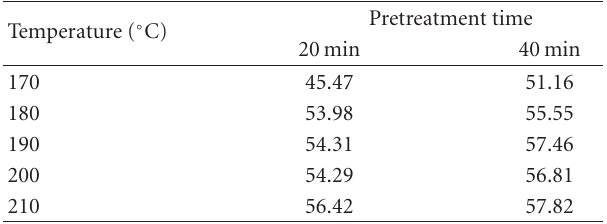
Table 2: Glucan contents of WIS in di ff erent pretreatment temperature and time (%, by weight of